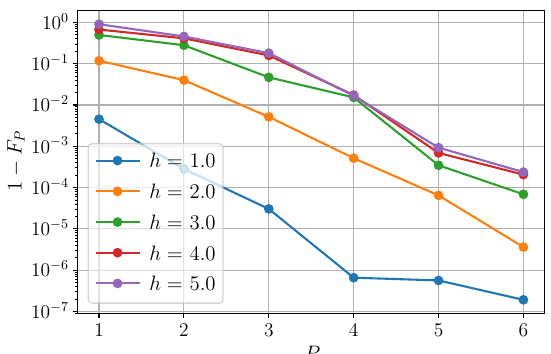
FIG. 6. Infidelity versus the number of QAOA layers P for L = 3 and several values of the magnetic coupling h . The ini- tial state is the electric ground state | (cid:5) E (cid:3) ; thus, the convergence towards the exact ground state is faster for smaller values of h